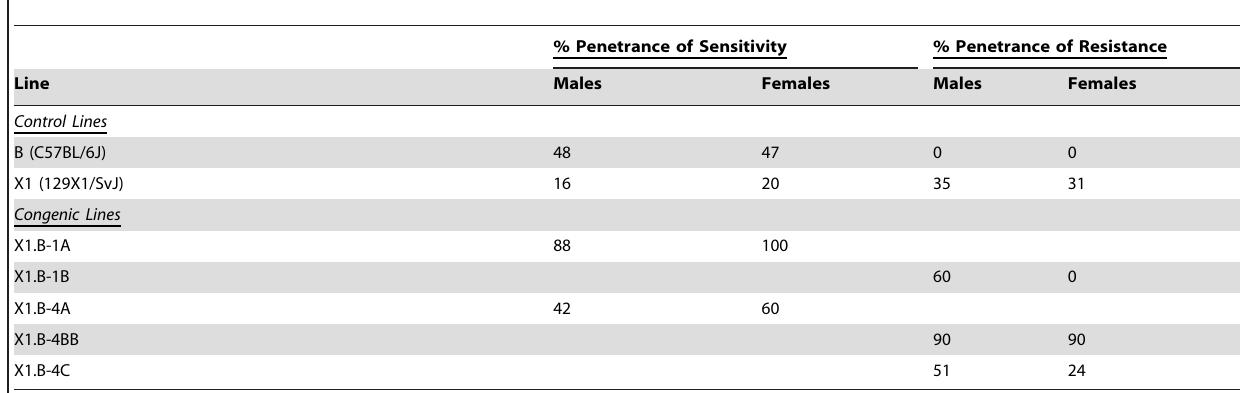
Table 1. Percent penetrance of sensitivity or resistance to hyperoxia-induced acute lung injury mortality.